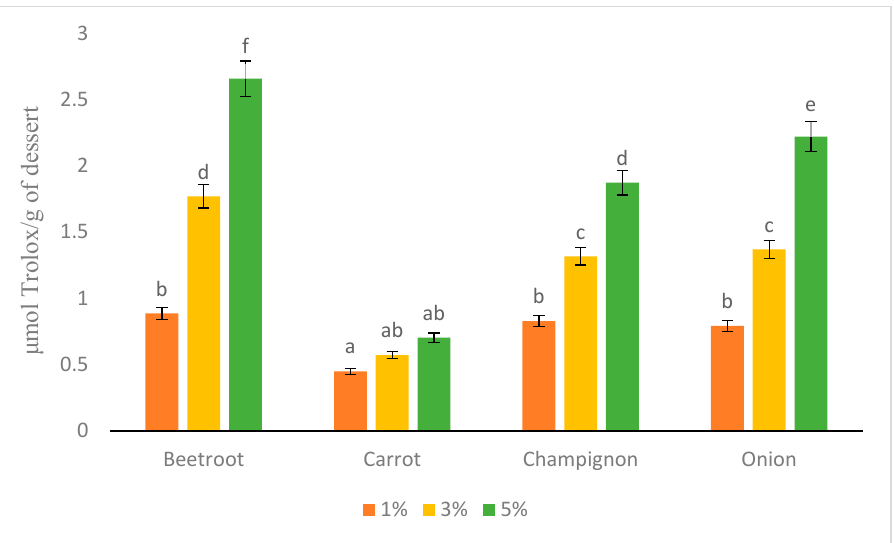
Figure 5. Effect of different amounts of vegetable powders on ferric reducing antioxidant power (FRAP) of fat ‐ free dairy desserts. Letters (a–f) indicate significant differences at p < 0.05 (Tukey’s HSD test).